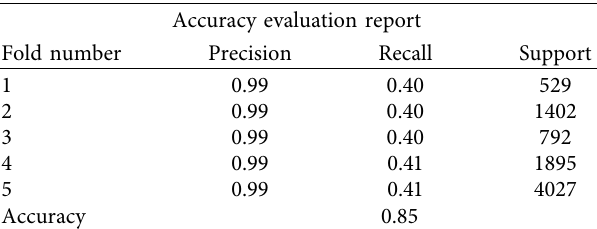
Table 3: Confusion matrix report registered by SVD model. Accuracy evaluation report Fold number